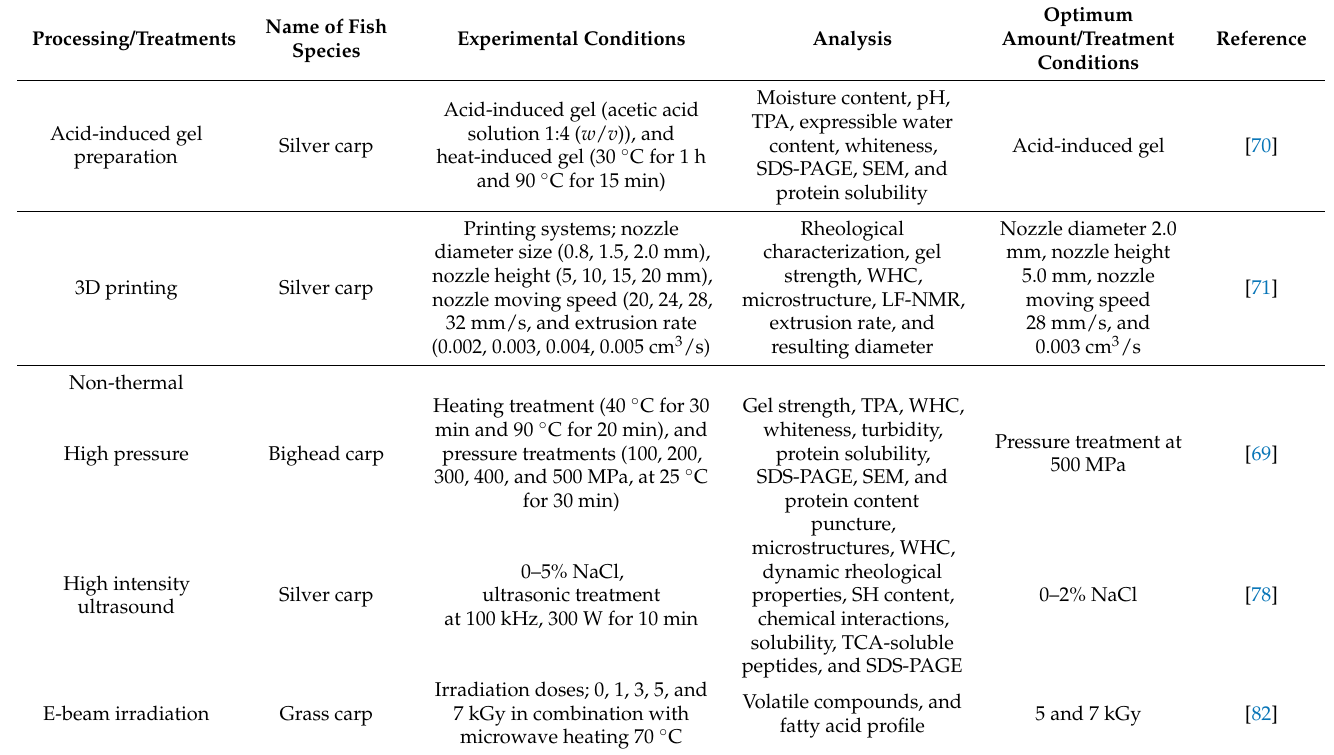
Table 1. The process progress to improve surimi